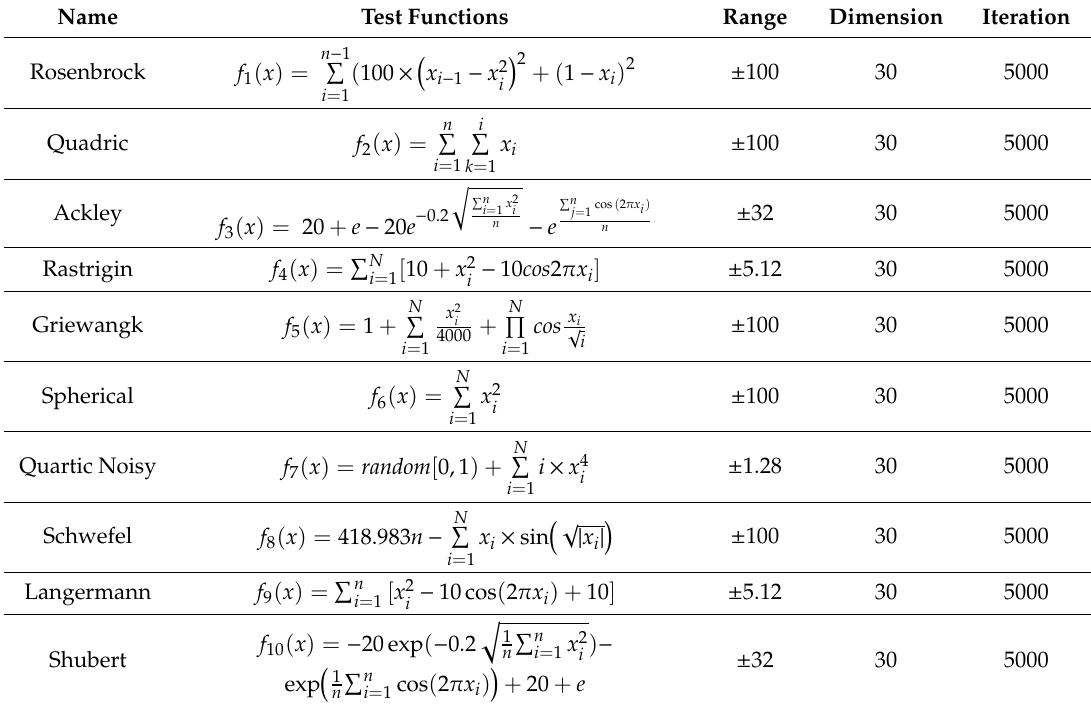
Table 1. Ten selected benchmark functions of